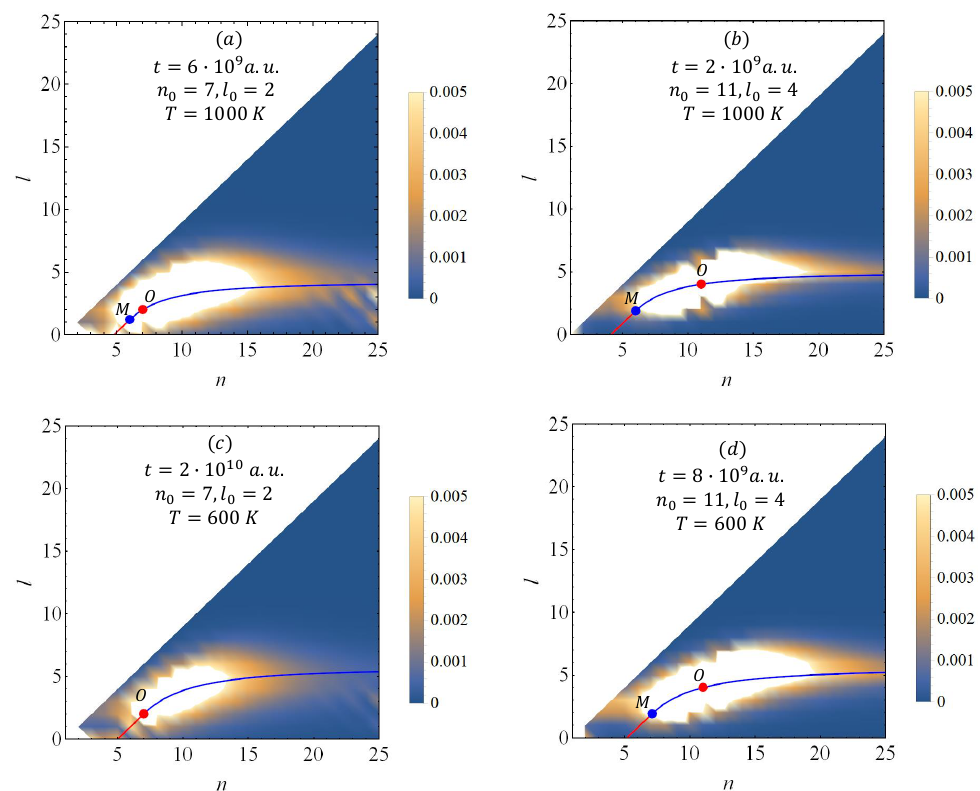
Figure 3. (Color online) The redistribution of the population within the space of quantum numbers n and l due to blackbody radiation. The magnitude of the population is shown in color, the red line is given by (7) and the blue line is given by (36) with Ω defined by (41). Point O indicates the initial state, and point M is the point of deflection (40) of the main path from the line